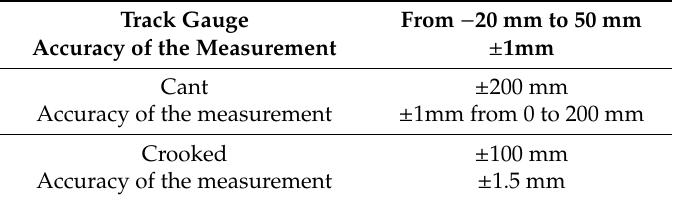
Figure 4. Amber [1,42].